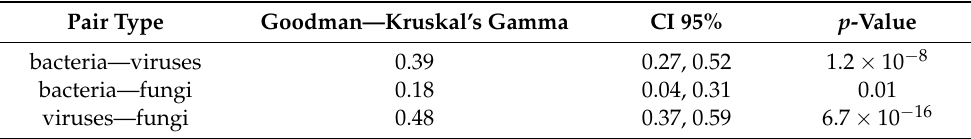
Table 2. Goodman–Kruskal’s gamma statistic for subjective associations between expected microbio- logical